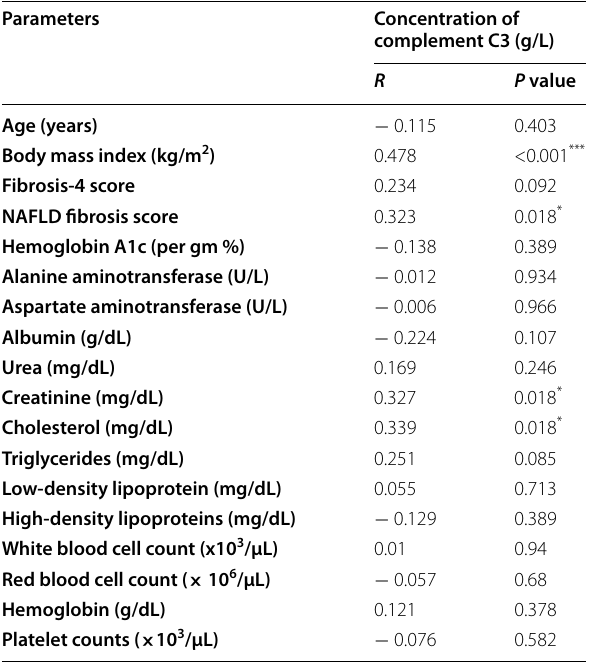
Table 1 Complement C3 levels in NAFLD and control group